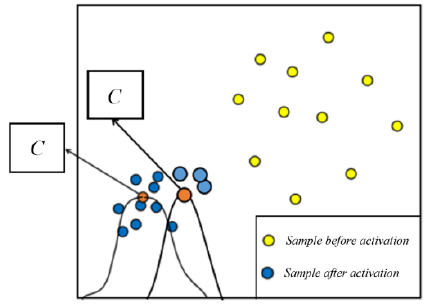
Figure 3. Dispersion of input samples after activation.